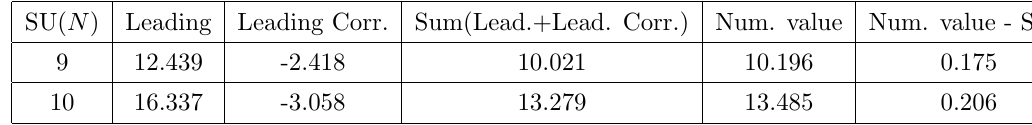
Table 15 . Comparison of N -ality 8 k -strings for SU(9